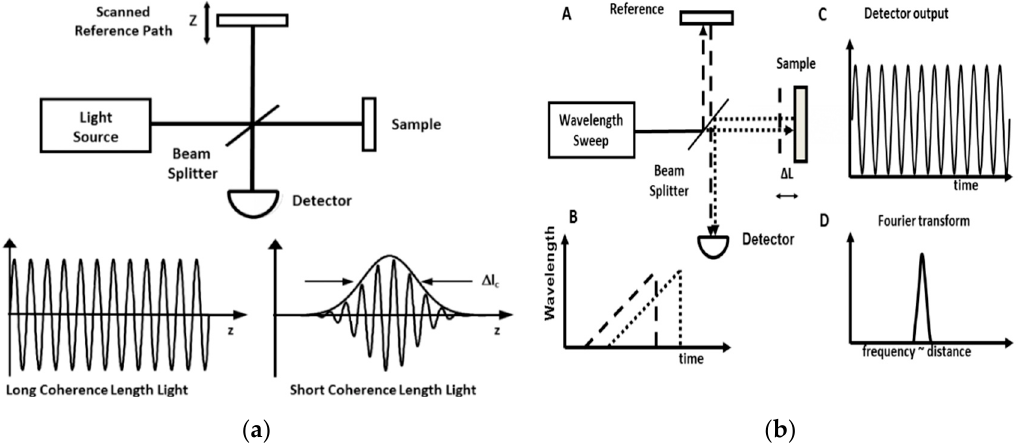
Figure 1. ( a ) Time-domain optical coherence tomography (TD-OCT) uses low coherence interferometry. The light source is split and the backscattered light is captured by the detector. The depth information is provided by the scanned reference path. Adapted from Tsai et al. 2014. ( b ). Swept-source optical coherence tomography (SS-OCT) allows 10–200-fold faster imaging compared to TD-OCT. ( A ) Interferometer with swept laser source and beam splitter and path difference Δ L. ( B ) Time delay of light from sample (dotted) and reference light (dashed). ( C ) Interference signal proportional to delay. ( D ) Fourier transform of the interference signal measures Δ L. Figure and caption adapted from Tsai et al. 2014.